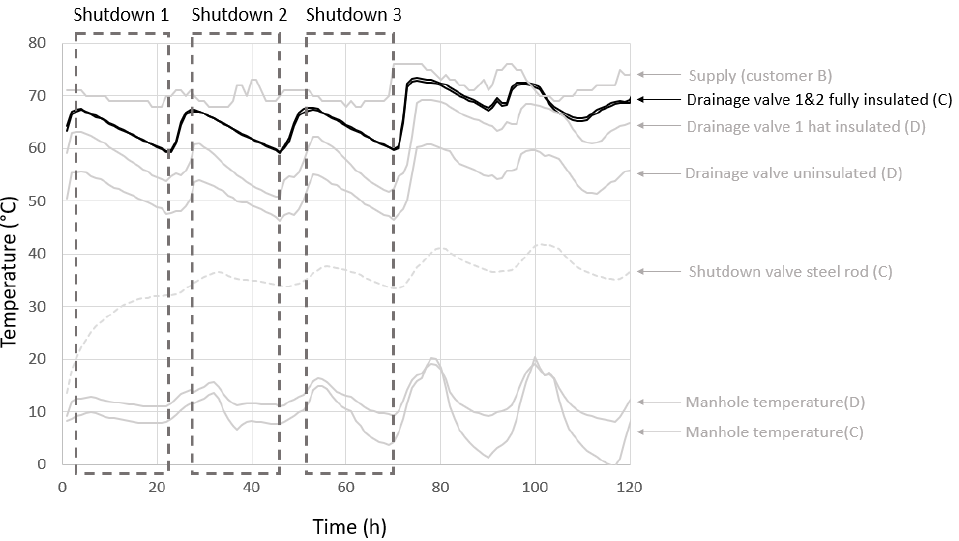
Figure 9. Measurement results for thermocouples with a focus on the drainage valves; the shutdown valve is included for comparison.